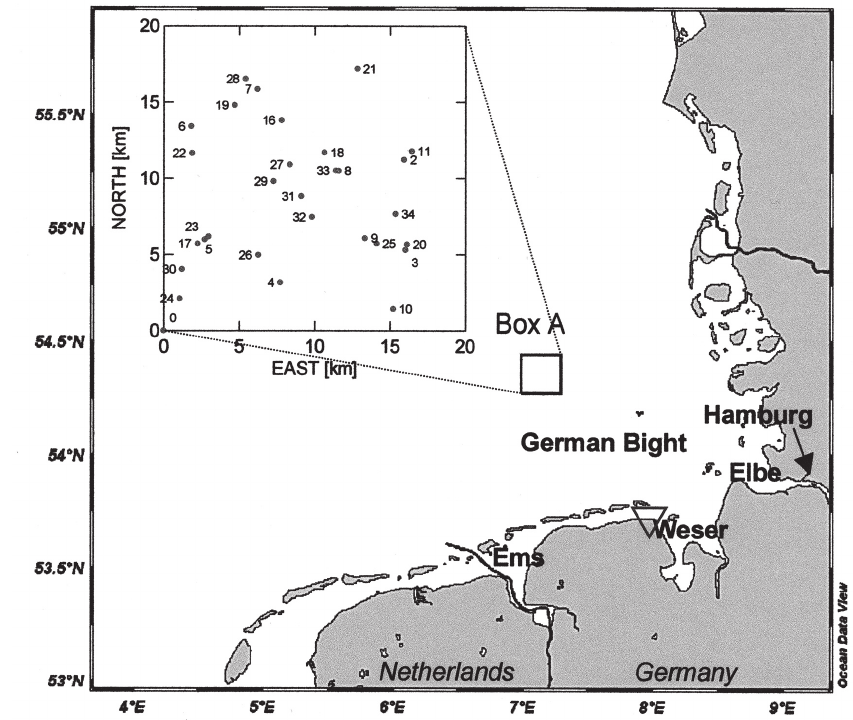
Fig . 1. – standard gsBts sampling area Box a and positions of the trawling midpoints from cruise 259 with FrV Walther Herwig III (January 05 – 13, 2004) in an area of the inner german Bight, southern north sea and sampling location for single specimen measurements in schillig (triangle), german north sea coast (July 2004 and 2005,